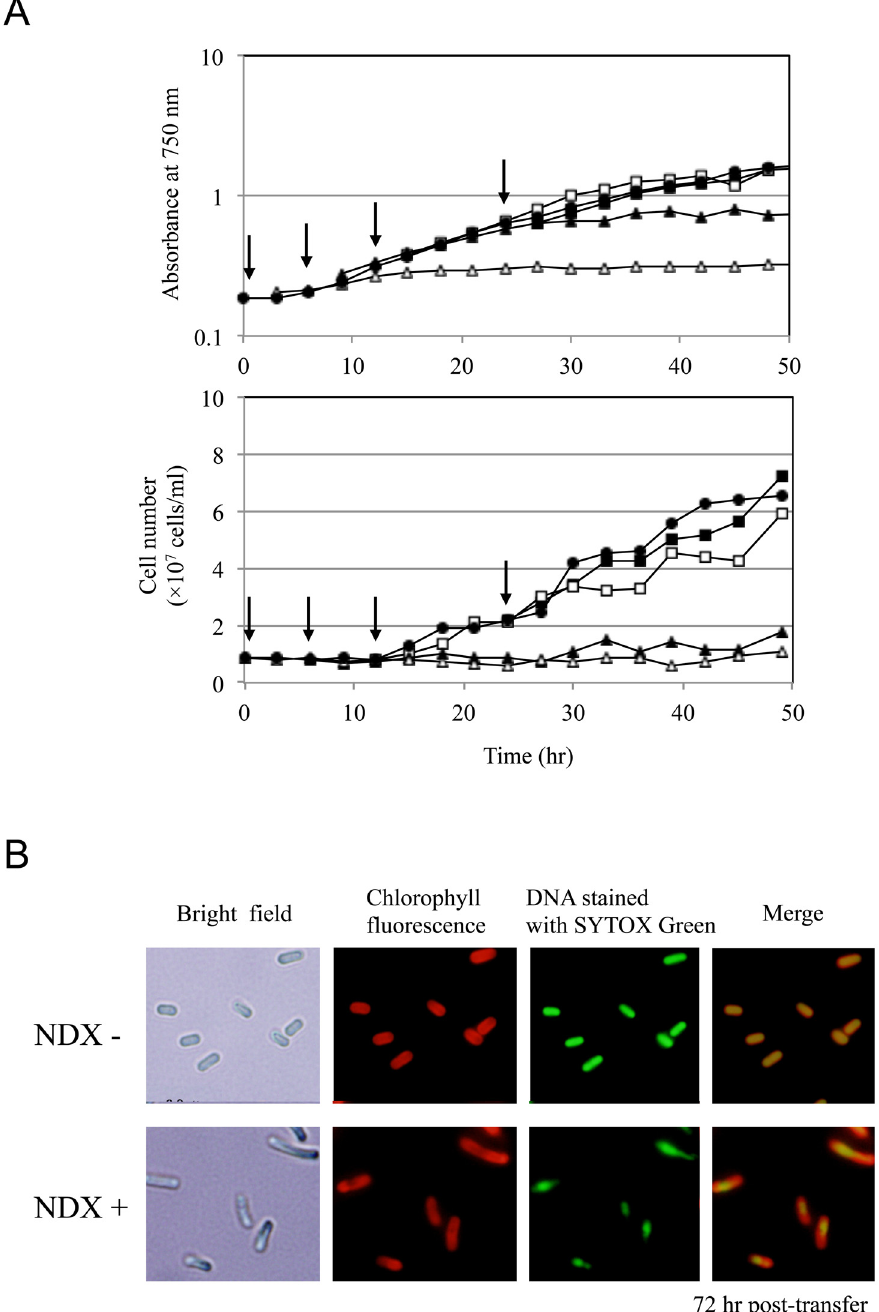
Fig 3. Differences in the effect of NDX at each phase. (A) Growth curve and cell numbers in the presence or absence of nalidixic acid (NDX). NDX (final concentration 3 μ g/mL) was added to synchronized Synechococcus 7942 wild-type cultures before (open triangles) exposure to light and then at 6 hr (closed triangles), 12 hr (open squares), and 24 hr (closed squares) after exposure. The control batch (without NDX) is indicated by closed circles. Arrows indicate the time points of NDX addition. (B) The effects of NDX addition at 12 hr post-transfer (before the onset of cell division). The cells were harvested at 72 hr post-transfer. Fixed cells were stained with SYTOX Green and examined with microscopy. Bright-field images (bright), SYTOX Green-stained images (SG), fluorescence images of chlorophyll (Chl), and merged images (SYTOX Green- stained and chlorophyll images) (Merge) are